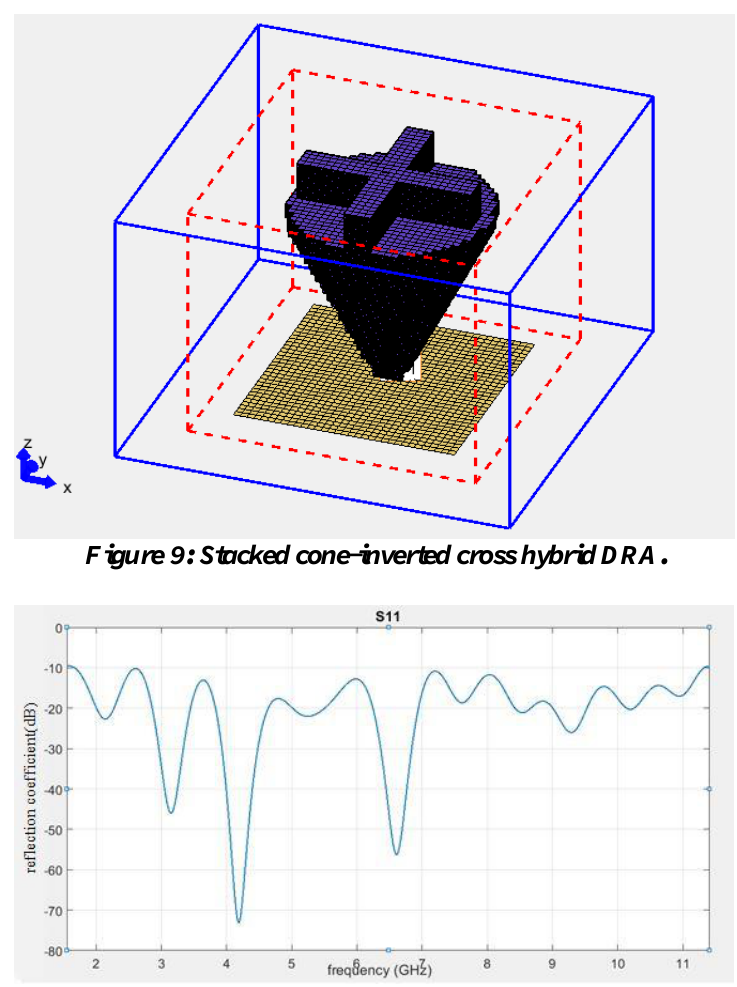
Figure 10: Return loss for cone-inverted cross hybrid